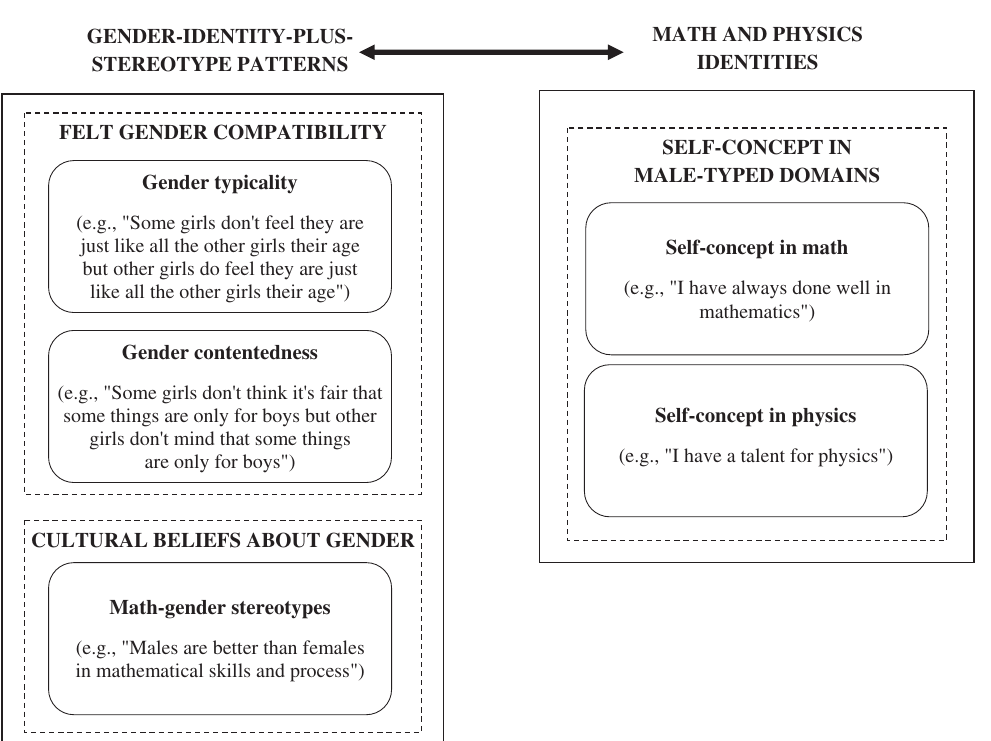
FIG. 1. Conceptual framework for the